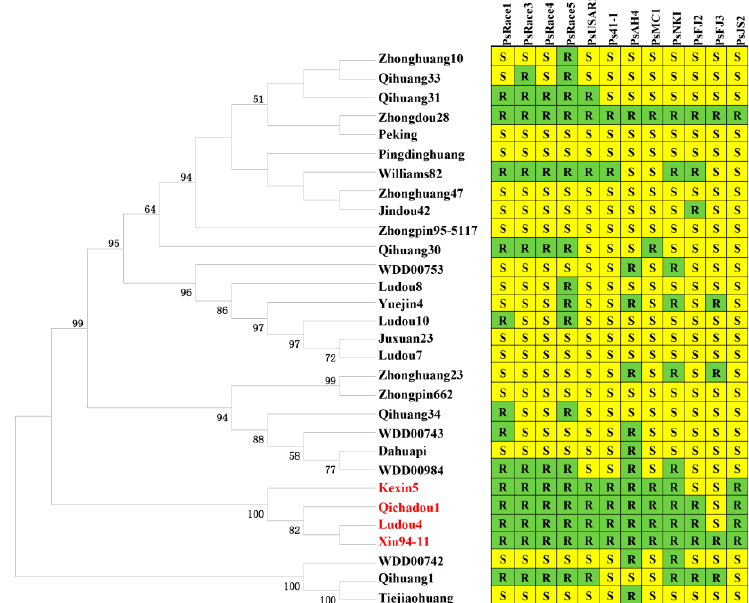
Figure 6. Phylogenetic tree constructed according to the neighbor-joining method using the allelic sequences of the candidate gene model Glyma.03g027200 in 30 soybean cultivars. The reactions of the cultivars to 12 P. sojae isolates are also presented.